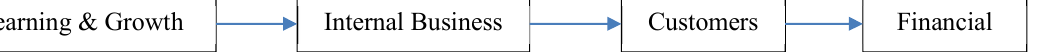
Fig. 1. Flows of Learning & Growth, Internal Business, Customers, and Financial